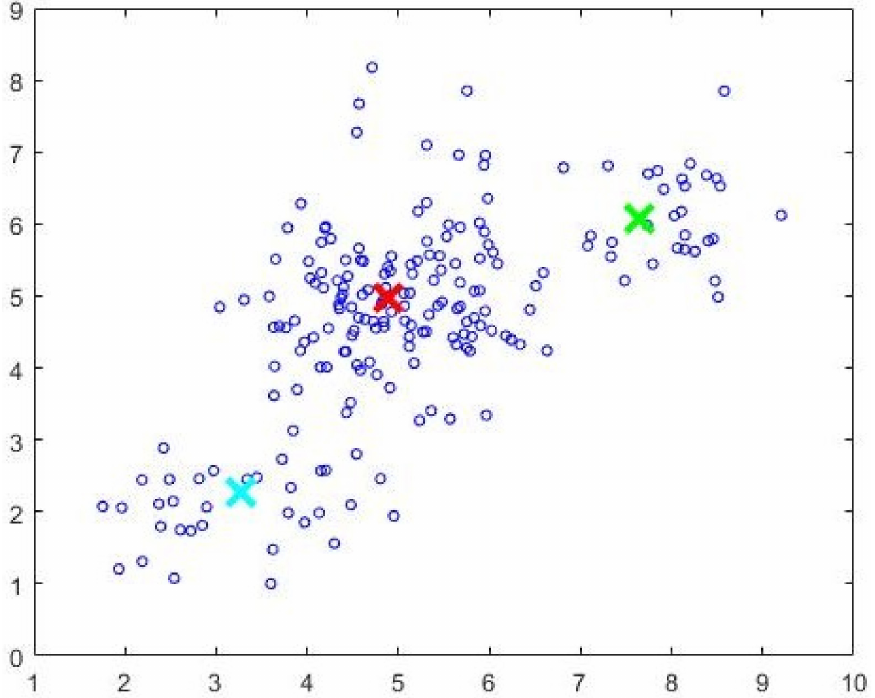
Figure 7. Initial cluster prototype as calculated by CDE on best subset of Data2. The Xs mark the initial cluster prototype